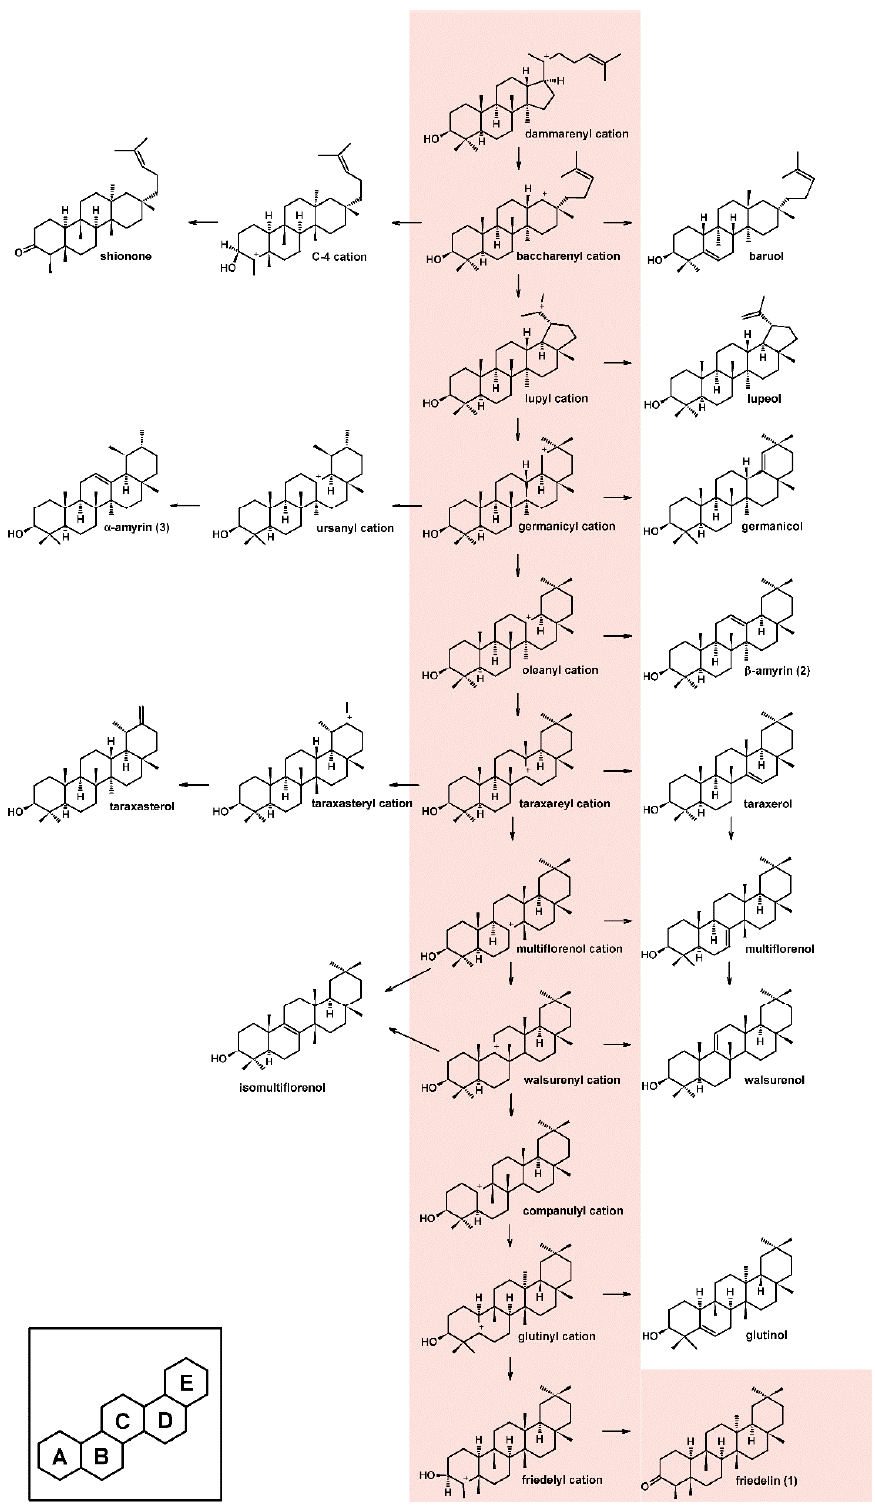
Figure 2. Cation rearrangement involved in the production of friedelin and other triterpenes [10]. Pink highlighted area represents the route of production of friedelin.